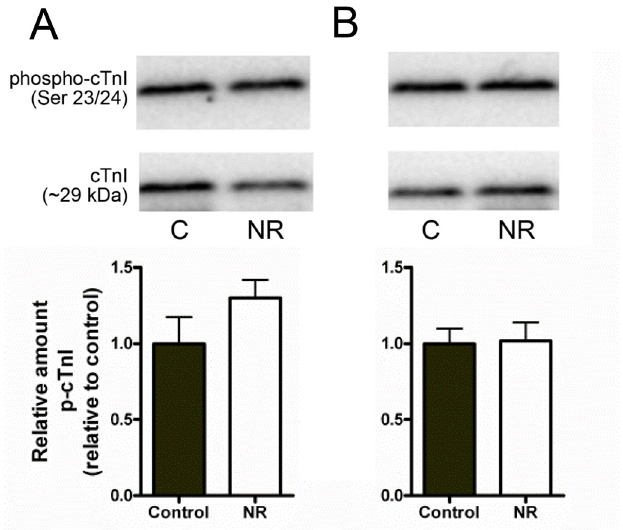
Fig 7. Western blot analysis of cTnI phosphorylation at Serine 23/24. Relative amount of cTnI phosphorylation at Serine 23/24 in (A) male and (B) female offspring, expressed as proportion of phosphorylation of entire (~29 kDa) cTnI protein content. No significant difference was observed between male Control (n = 10) and NR (n = 8; P = 0.09), or female Control (n = 8) and NR (n = 10; P > 0.05) samples.